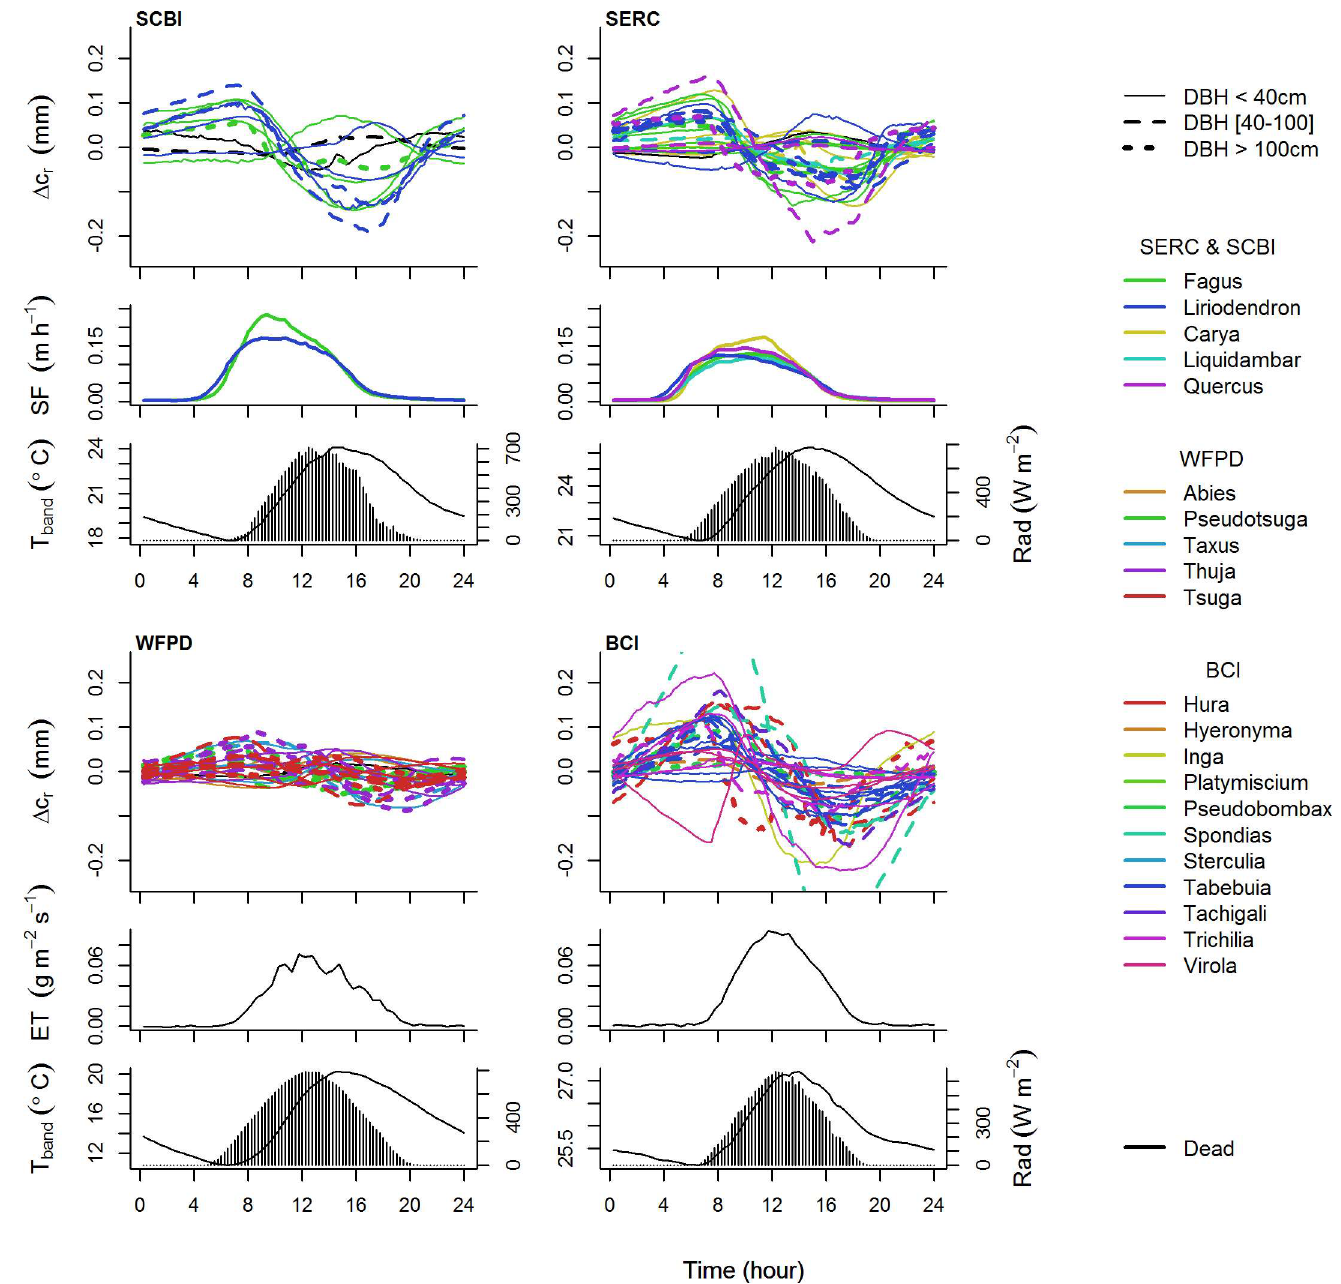
Fig 4. Averagedaily patterns in stem circumference relative to other variables. Average daily patterns in Δ c r , sap flow ( SF ; averagedby genus) or evapotranspiration(ET), temperature ( T band ), and radiation( Rad ) on non-raindays duringanalysisperiodfrom the four study sites. For Δ c r , line type indicatessize class, and lines are colored by genus as indicatedin the legends. T band is plotted as solid line, Rad as